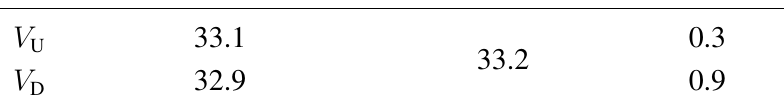
Table 3. Deutsches museum step height